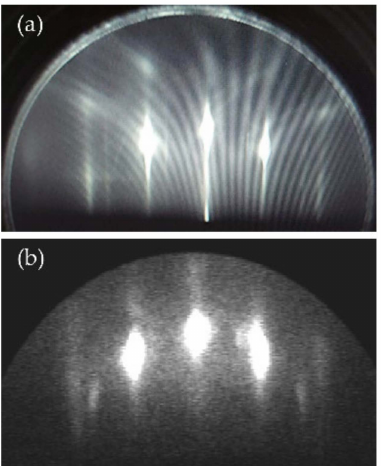
Figure 5. ( a ) The RHEED and ( b ) TRHEPD pattern of the epitaxial χ 3 -borophene on